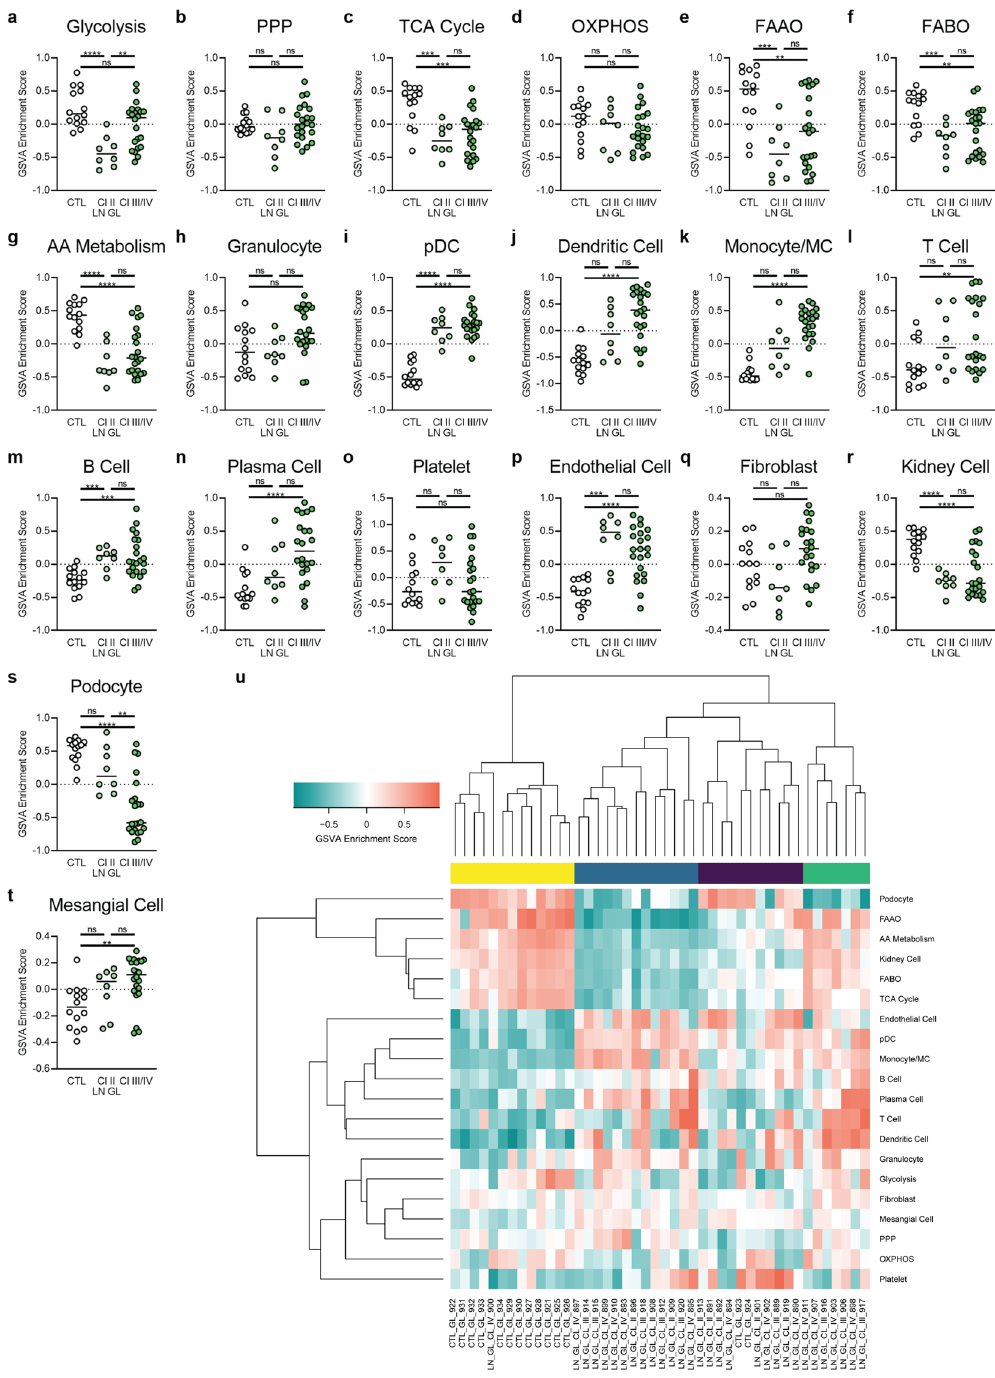
Figure 3. Metabolic and cellular signature changes in class II LN GL are similar to those seen in class III/ IV. GSVA of ( a – g ) metabolic pathway signatures and ( h – t ) cell signatures in all classes of LN GL. Each point represents an individual sample. Significant differences in enrichment of the metabolic signatures, immune cell signatures, or non-hematopoietic cell signatures between class II LN GL and CTL, class III/IV LN GL and CTL, and class II LN GL and class III/IV LN GL were performed by Welch’s t-test with Bonferroni correction. ( u ) Hierarchical clustering (k = 4) of all glomerular samples. For all calculations, the following sample numbers were used: LN GL [CTL (n = 14), Cl II (n = 8), Cl III/IV (n = 22)]. **, p < 0.01; ***, p < 0.001; ****, p <